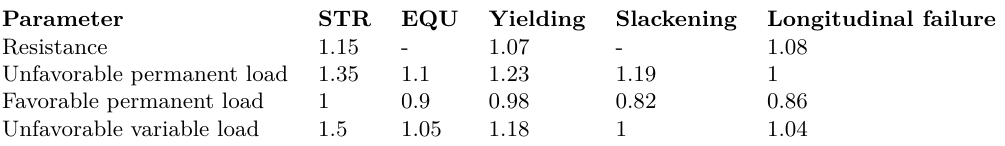
Table 4. Summary of the resulting partial factors from the